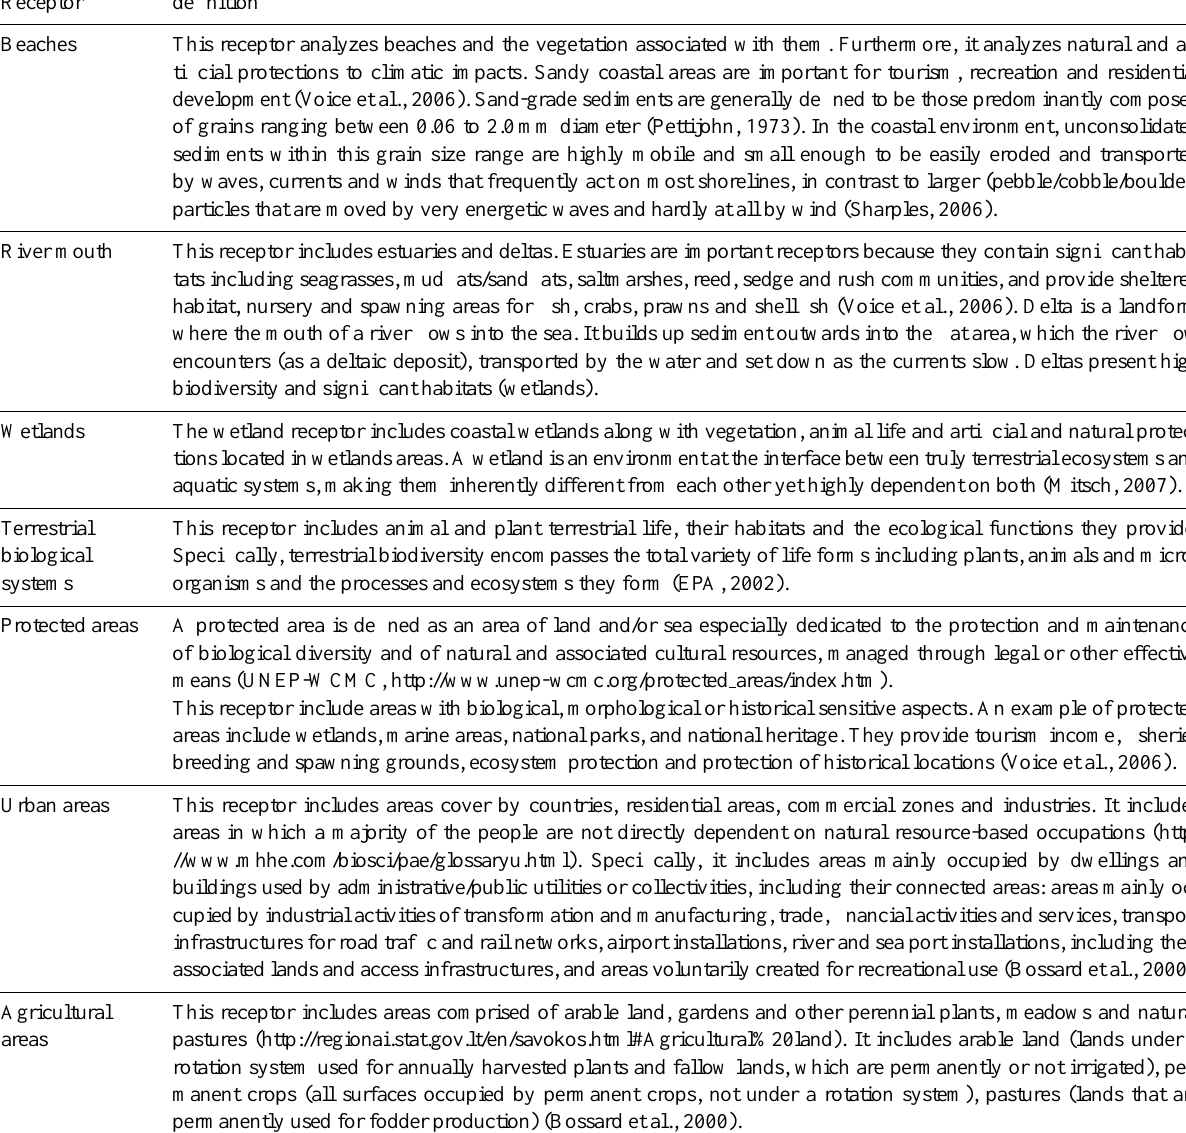
Table 3. Description of the receptors included in the vulnerability matrix and identified as targets of the regional vulnerability assessment methodology applied to the North Adriatic